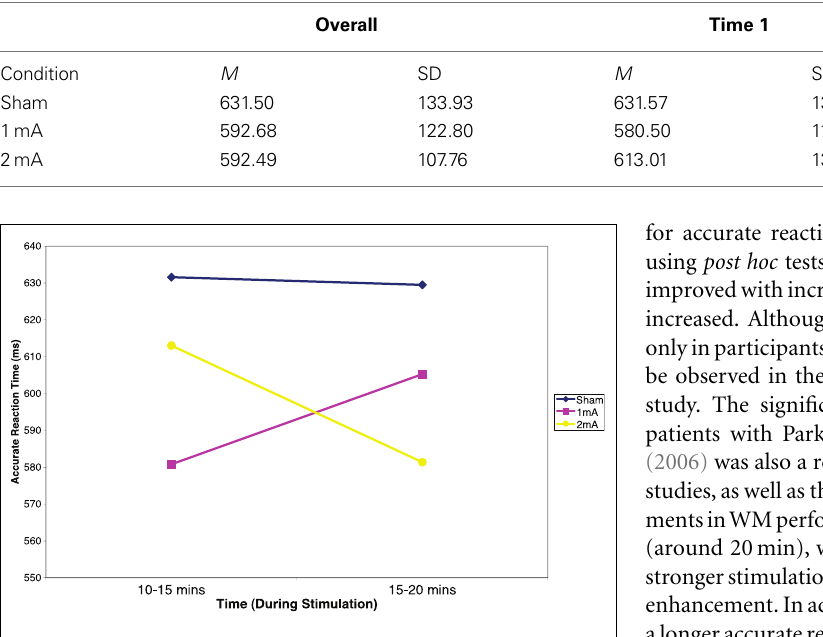
Table 1 | Mean and SD for accurate reaction time of 3-back by current and time.